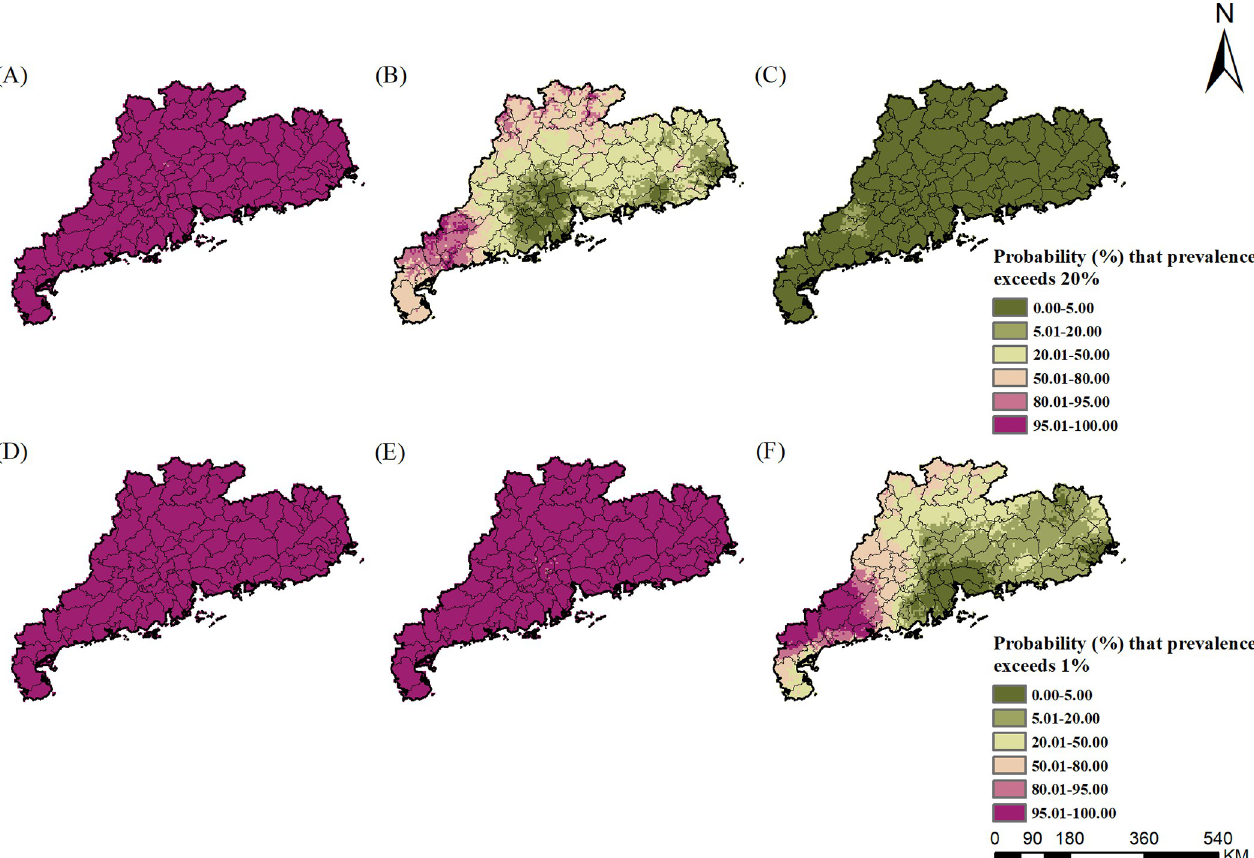
Fig 6. Probability contour maps of any STH infection risk in Guangdong. (A)-(C) present the probability that prevalence exceeds the threshold for preventive chemotherapy (20%); (D)-(F) present the probability that prevalence exceeds the threshold of transmission control (1%), during the periods of 1988–1992, 2002–2003, and 2015–2016, respectively. The base layer derived from https://www.webmap.cn/mapDataAction.do?method=forw&keysearch= indexSearch with credit to National Catalogue Service For Geographic